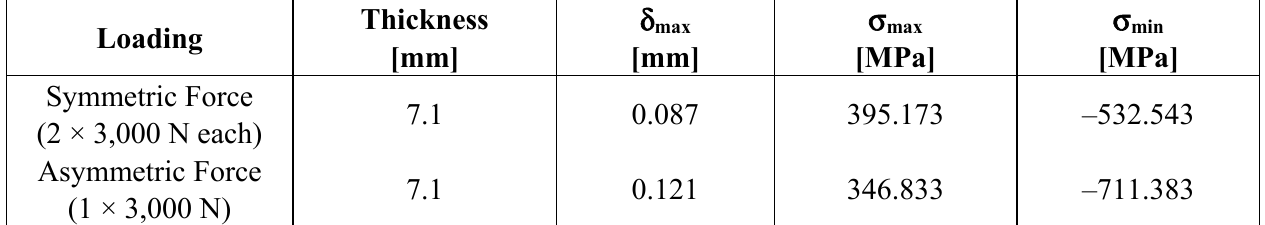
Table 2. Main normal stresses and maximum displacements for symmetric and